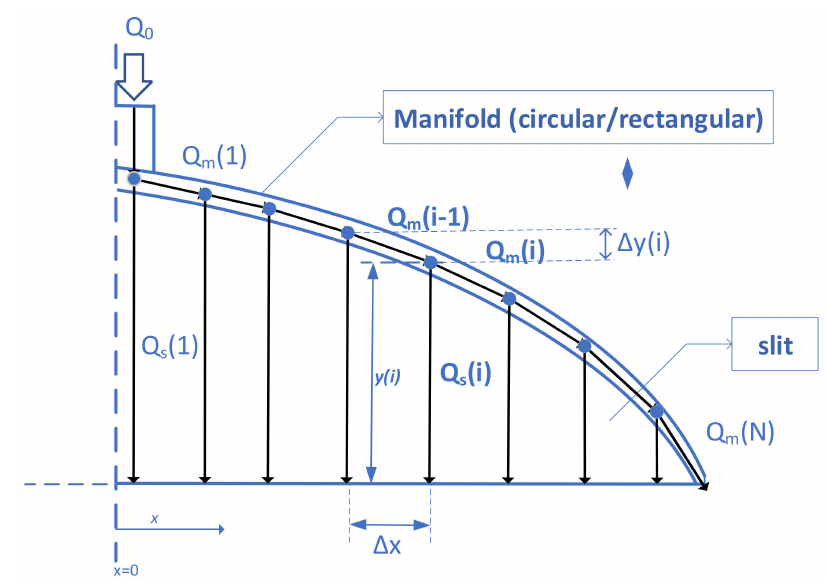
Figure 1. Schematic of a sheeting extrusion die and the corresponding flow